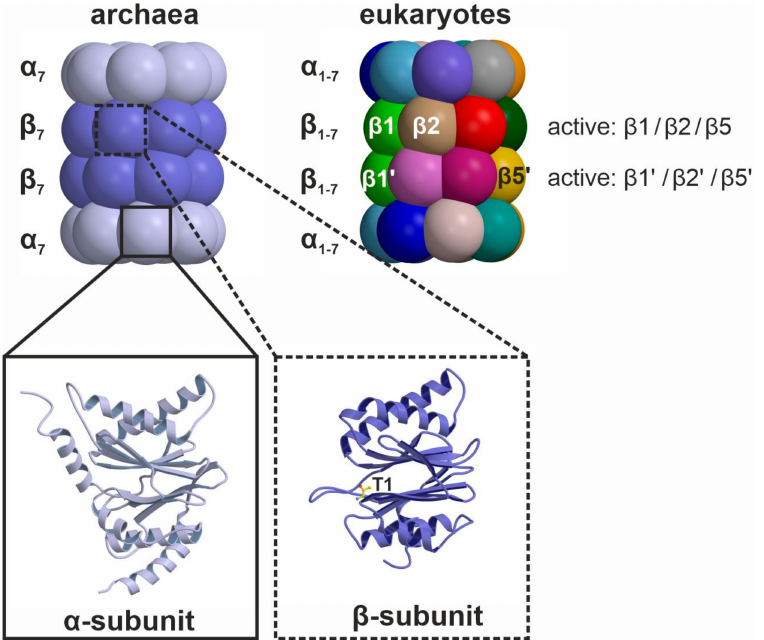
Figure 1. Schematic illustration of archaeal and eukaryotic 20S proteasomes. Simple archaeal 20S proteasome core particles are built of four homo-oligomeric α - and β -rings. Being identical and harboring a catalytic Thr1 residue, all β -subunits are proteolytically active. In contrast, eukaryotic CPs bear hetero-oligomeric α - and β -rings and only three of the seven distinct β -subunits per ring, namely β 1, β 2 and β 5, feature an active site. Note that one β 2- and one β 5-subunit are hidden in the back of the particle.